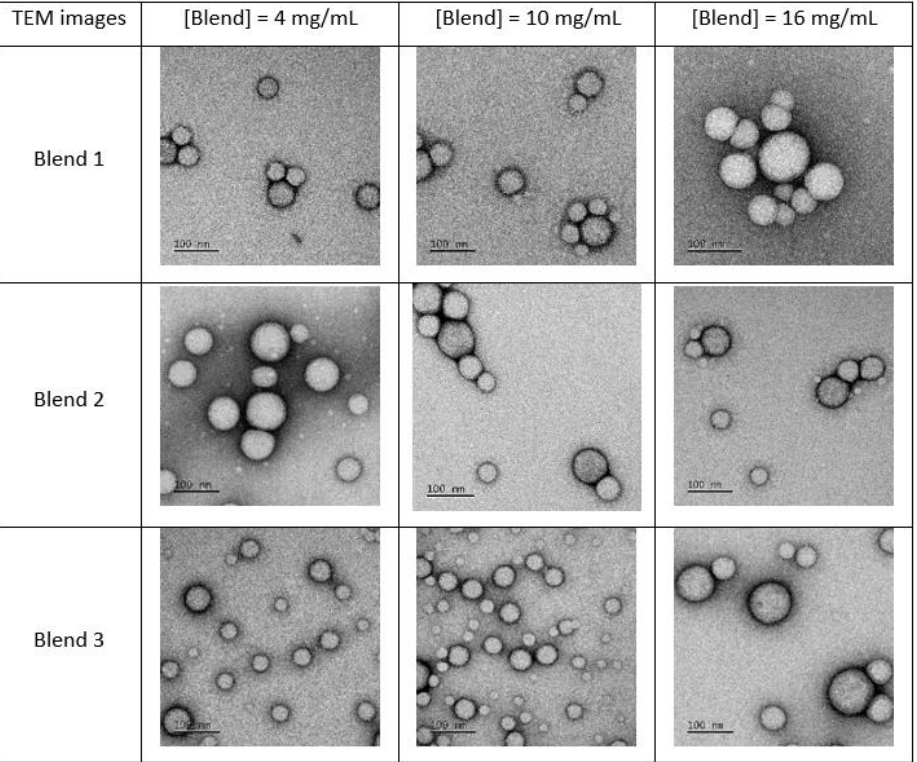
Figure 3. Typical TEM images of nanocarriers obtained from blends 1, 2 and 3, with increasing concentrations.